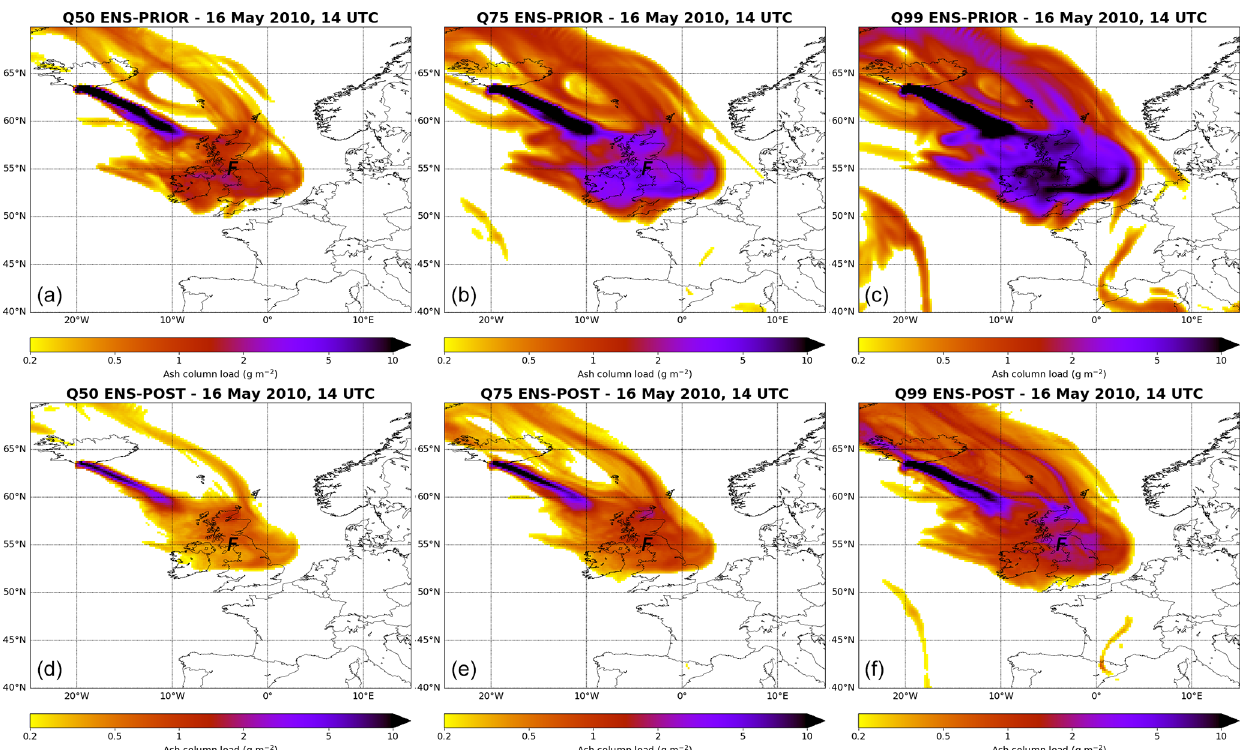
Figure 7. Ash column load on 16 May at 14:00UTC for the a priori (a–c) and for the a posteriori (d–f) ensembles. The ensemble median ( Q 50), 75th percentile ( Q 75), and 99th percentile ( Q 99) are respectively displayed from left to